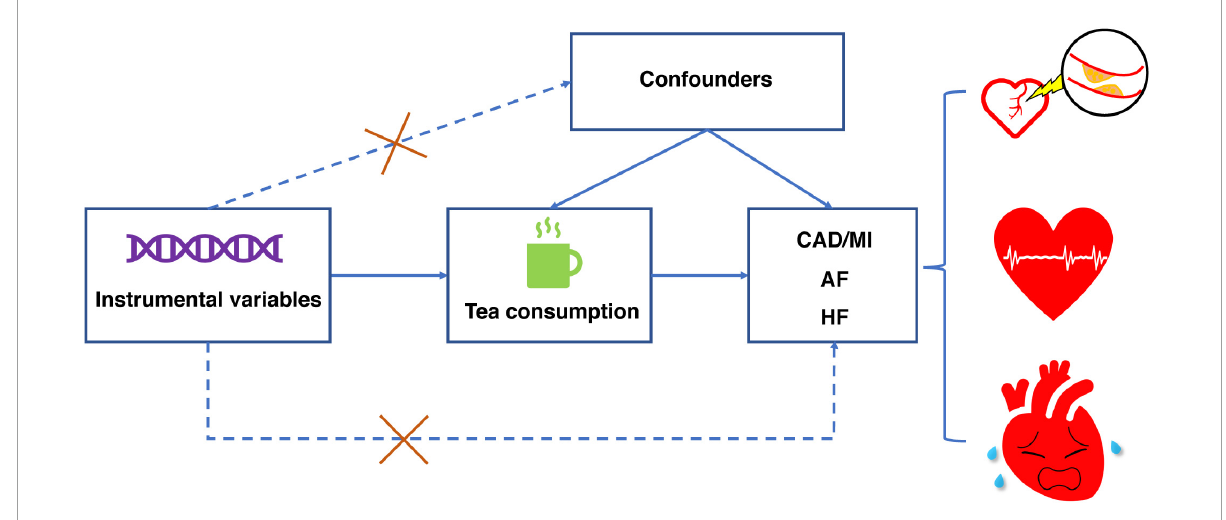
FIGURE1 Design of Mendelian randomization study of tea consumption and risk of cardiovascular diseases. This Mendelian randomization study builds upon the assumptions that instrumental variables are associated with tea consumption but not with confounders, and that instrumental variables affect the risk of the four cardiovascular diseases only through tea consumption. CAD, coronary artery disease; MI, myocardial infarction; AF, atrial fibrillation; HF, heart